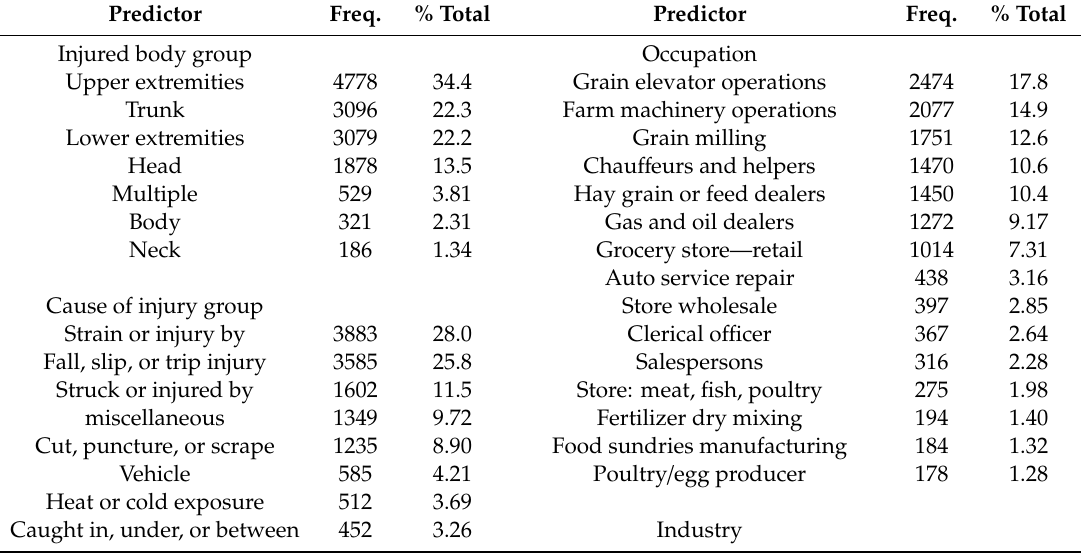
Table 1. Distribution of individual